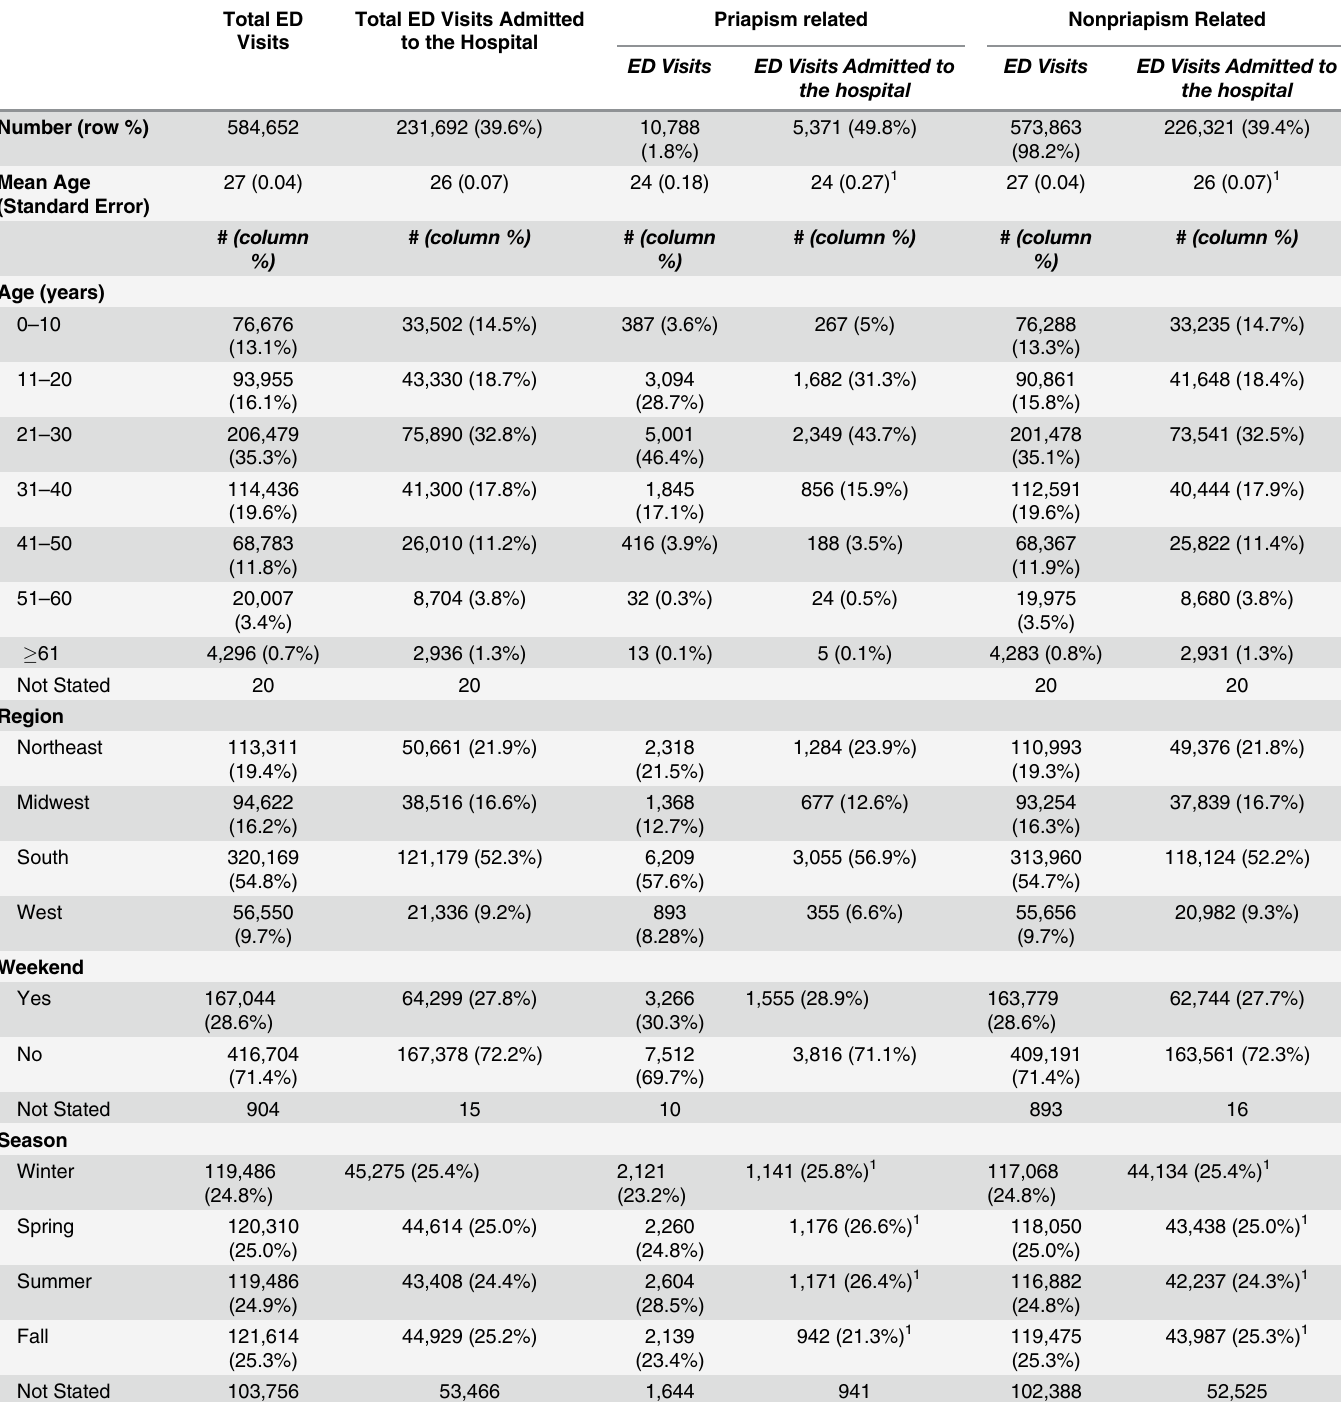
Table 1. Selected characteristics of emergency department visits and hospitalizations by patients with sickle cell disease, 2006 –